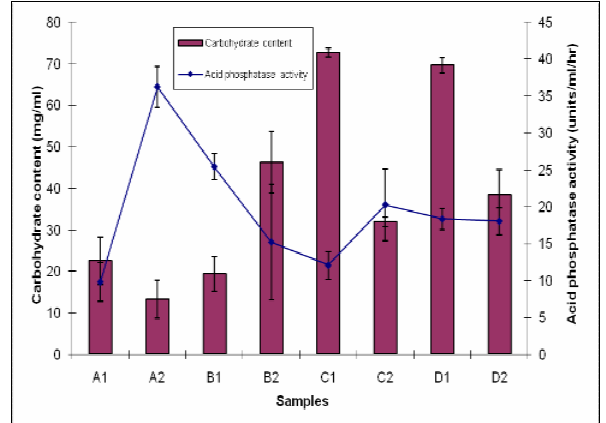
Fig. 3. Carbohydrate content in relation to alkaline phosphatase activity of the raw milk samples